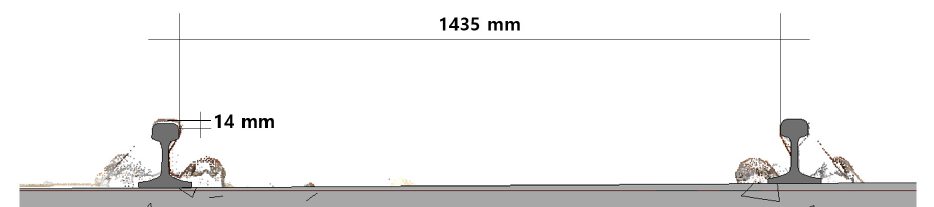
Figure 10. Track gauge review.